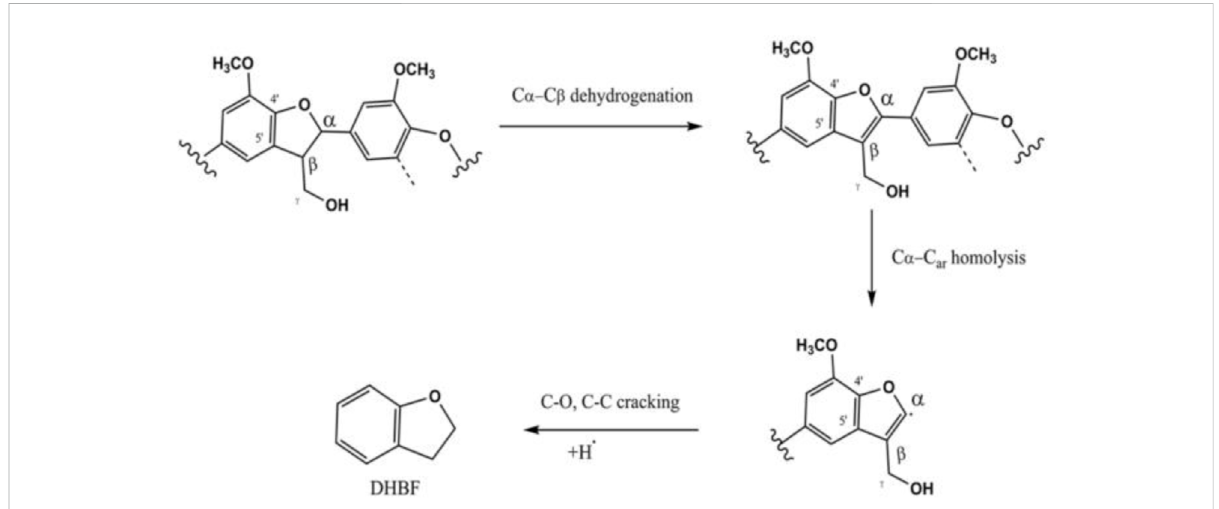
FIGURE 5 Possible mechanisms of DHBF production.